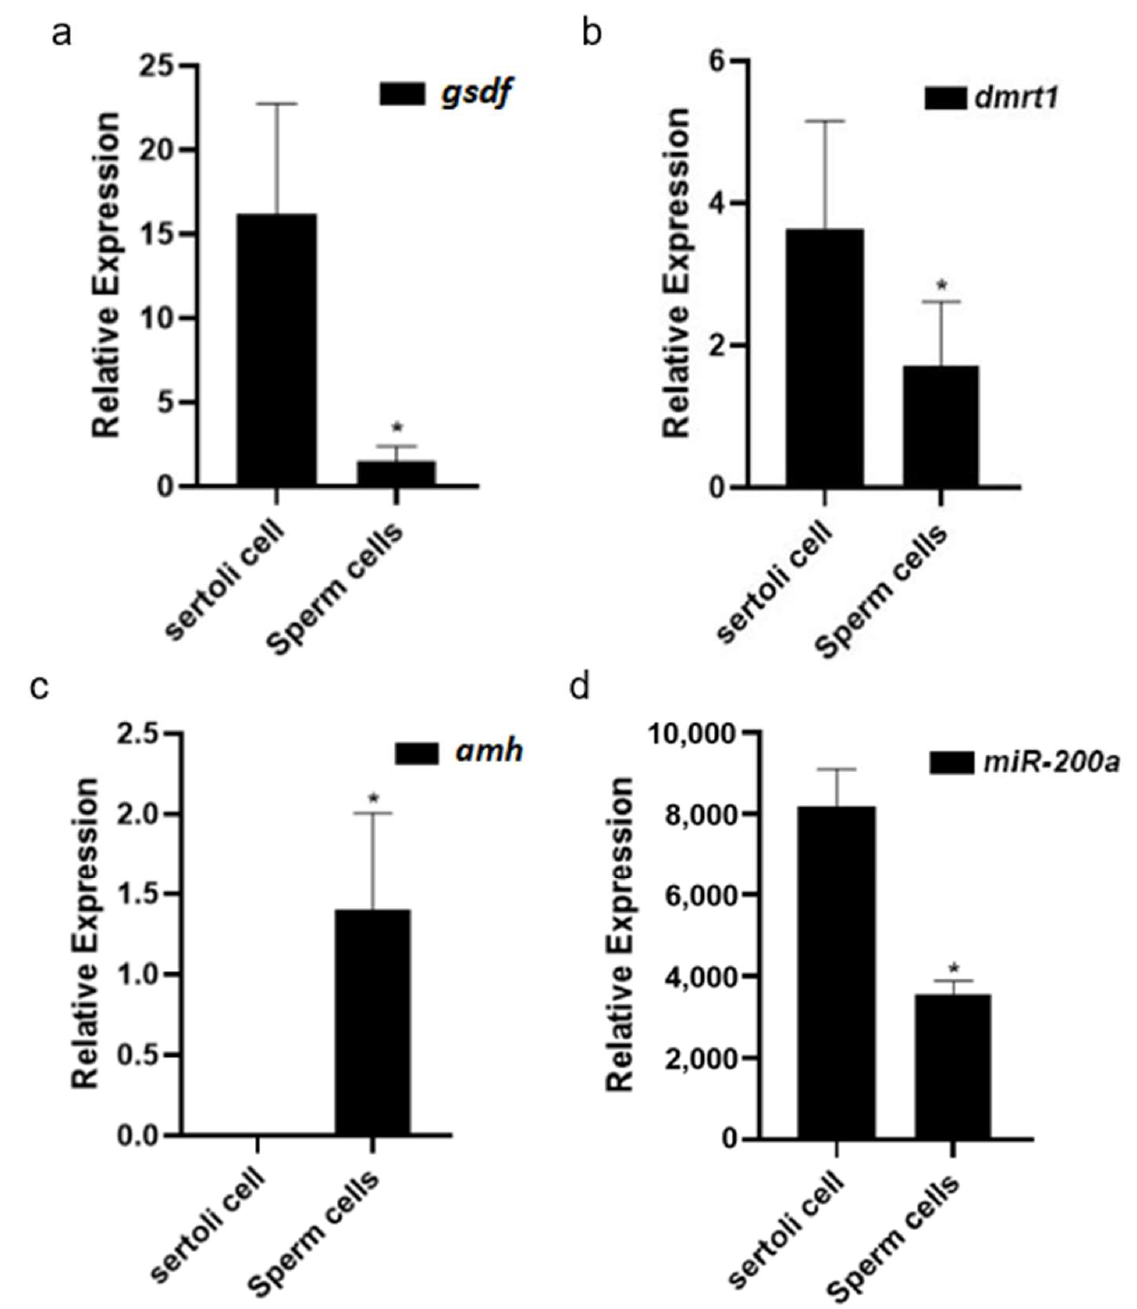
Figure 6. The expression difference of ( a ) amh , ( b ) dmrt1 , ( c ) vasa , and ( d ) miR200a in the Sertoli cells and germ cells. * Indicates that there is a statistically significant difference ( p < 0.05). 3.5. Expression Changes of amh, dmrt1 and gsdf after Overexpression of miR-200a The miR-200a mimics were transfected into the primary Sertoli cells of the Japanese flounder testis. The level of miR-200a increased significantly after 24 h of transfection (Figure 7a). As the miR-200a level increased, the expression of amh decreased significantly (Figure 7b). However, the expression of the other two male sex-related genes dmrt1 and gsdf increased significantly (Figure